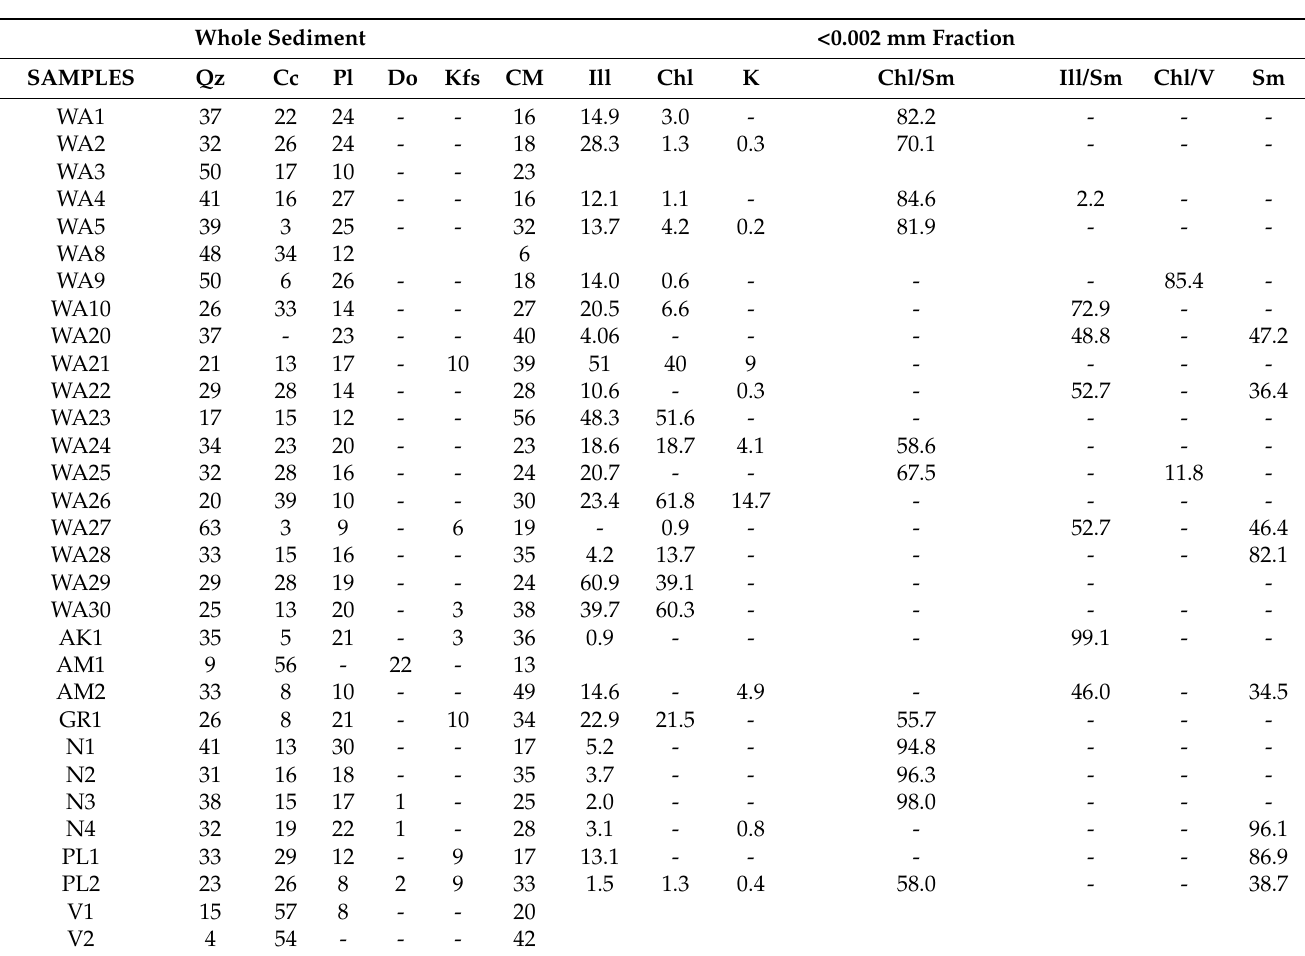
Table 2. Mineralogical composition of the whole-sediment and of the <0.002 mm fraction of the investigated clayey raw materials (relative abundance %) (Legend: Qz = Quartz; Kfs = K-feldspar; Cc = Calcite; Do = Dolomite; Pl = Plagioclase; CM = total clay minerals; K = Kaolinite; Chl =